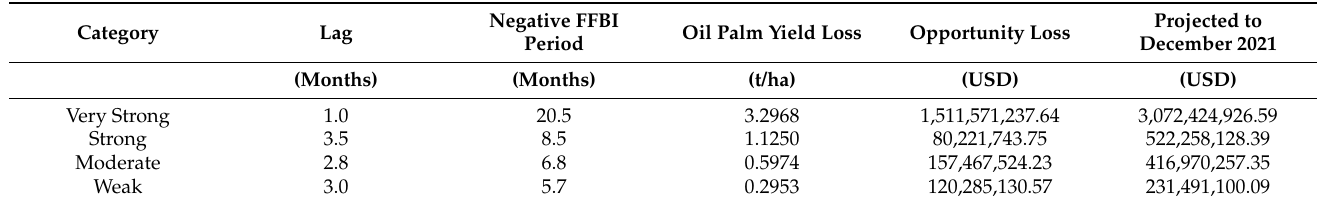
Table 9. Averaged oil palm yield loss and opportunity loss due El Niño according to category.